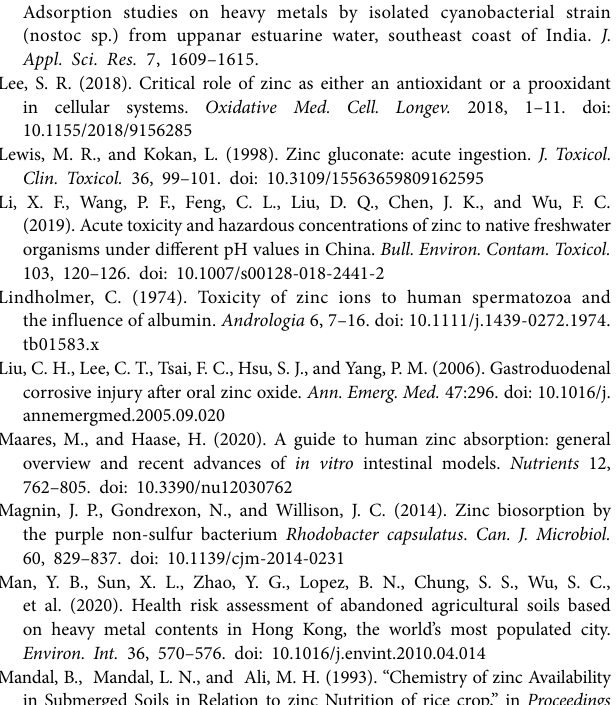
table. J. Chem. Ed. 80, 952–961. doi: 10.1021/ed080p952 Johnson, F. A., and Stonehill, R. B. (1961). Chemical pneumonitis from